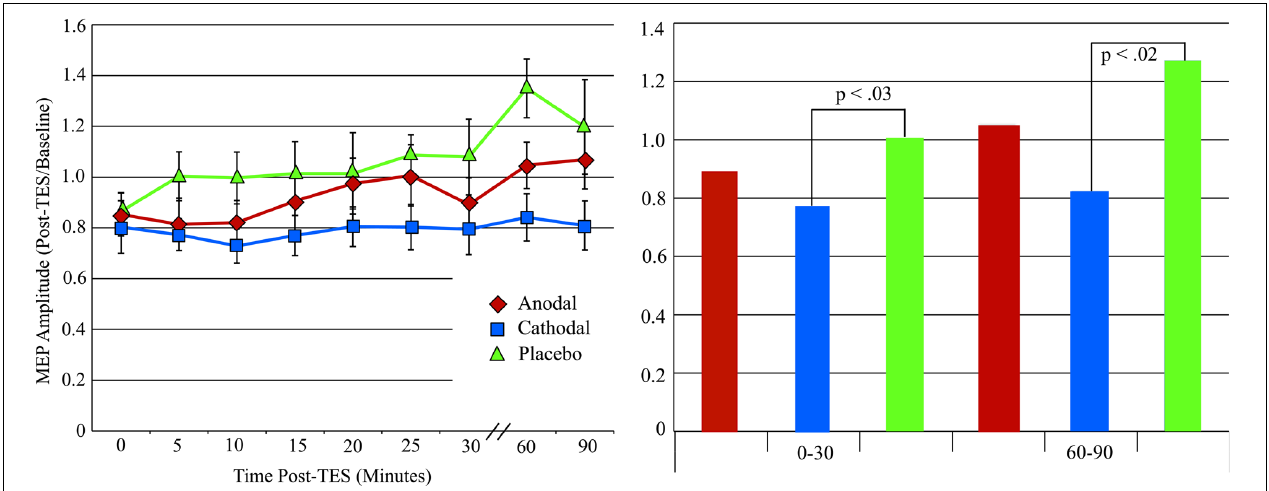
FIGURE 3 | (Left) Motor evoked potentials amplitude changes after tPCS with error bars (standard error of the mean). (Right) MEP amplitude changes after tPCS grouped by time after stimulation.